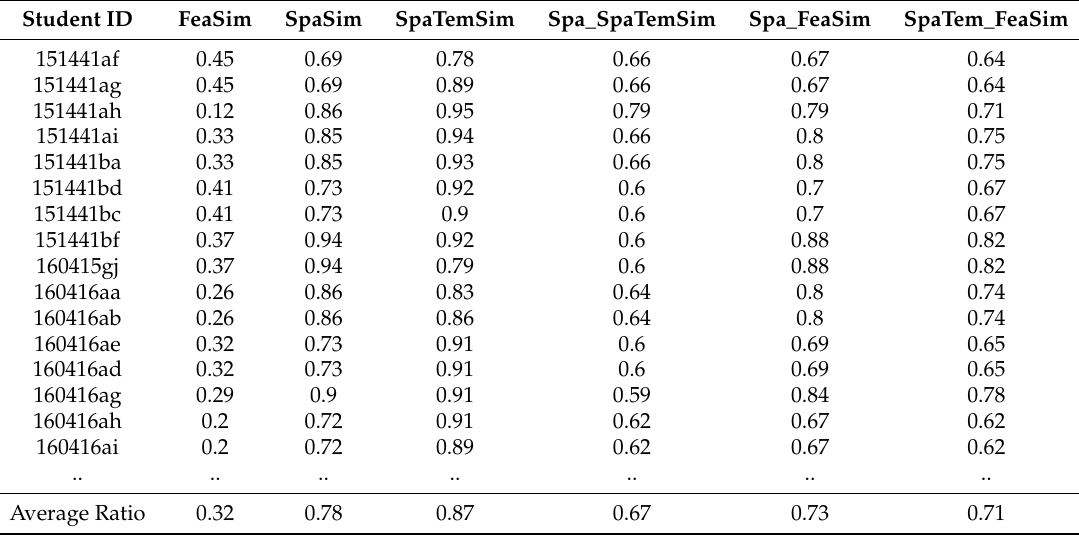
Table 2. Accuracy computed via six similarity